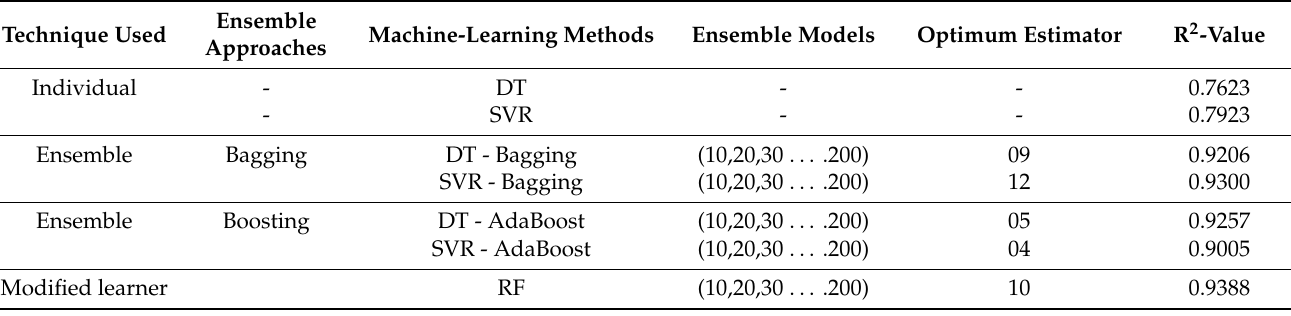
Table 4. N-estimator response of